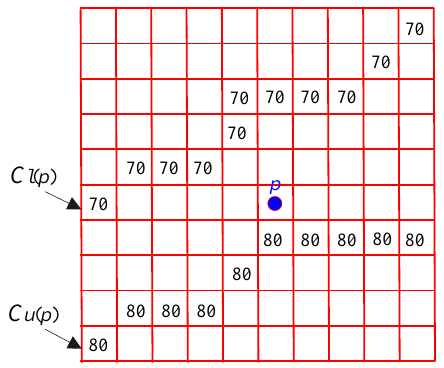
Figure 1. The upper contour line and the lower contour line associated with some a pixel p As for each pixel point, if the following two elevation images Pl (lower plateau image) and Pu (upper plateau image) can